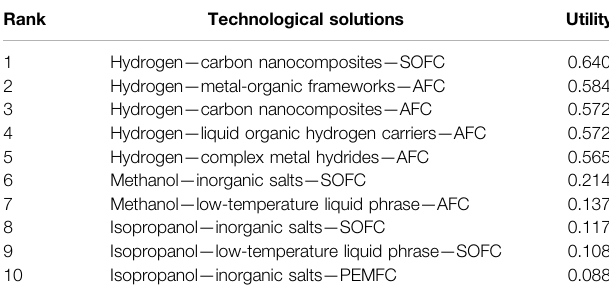
TABLE 5 | The top 10 technological solutions in the conceptual